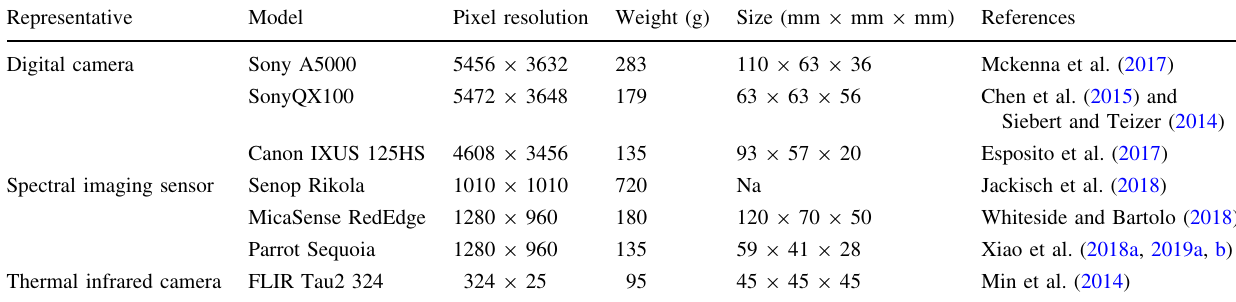
Table 3 Specifications of the sensors discussed in the text